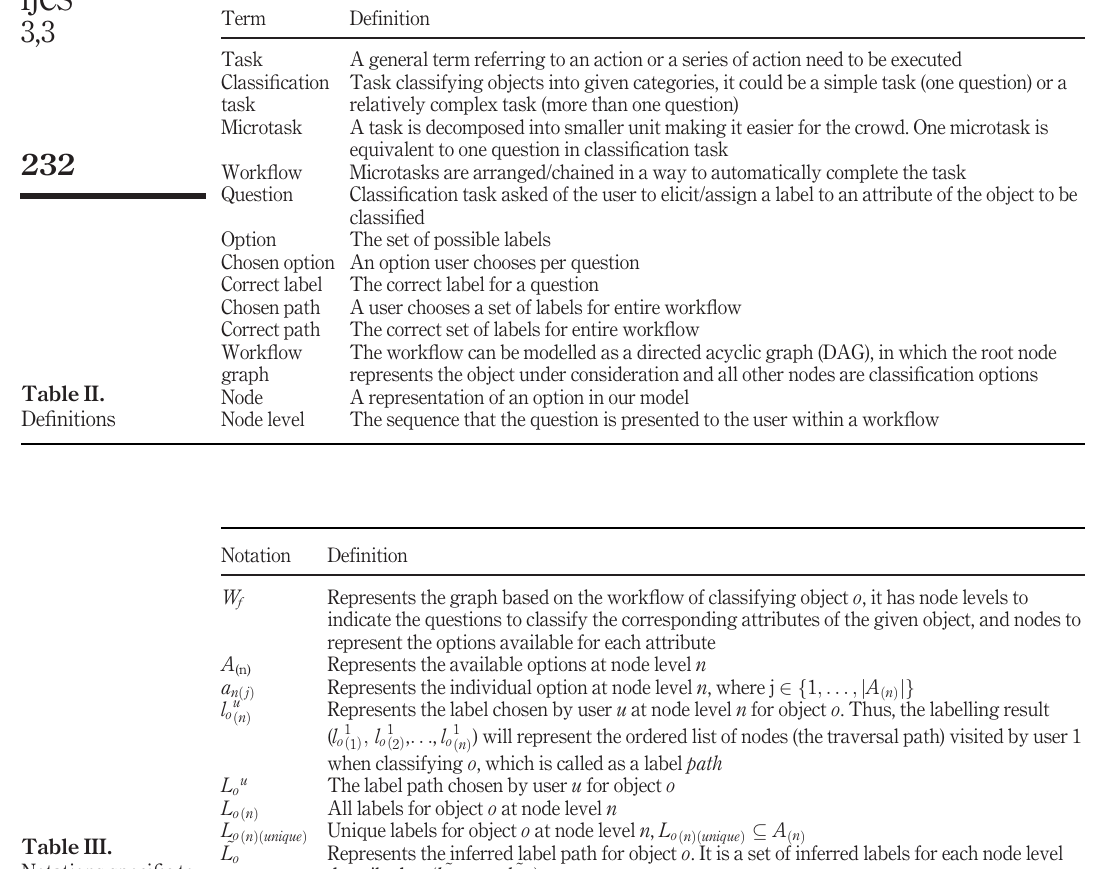
Table III. Notations speci fi c